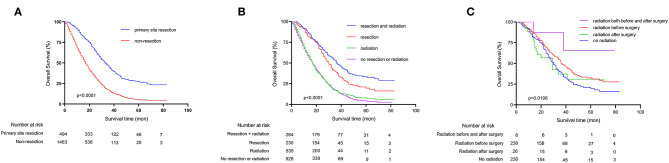
Kaplan-Meier survival curves depicting survival in unresectable metastatic rectal cancer patients. (A) Patients OS based on whether primary tumor was surgically resected or not. (B) Patients OS based on detailed treatment modality. (C) Patients OS based on radiation sequences.